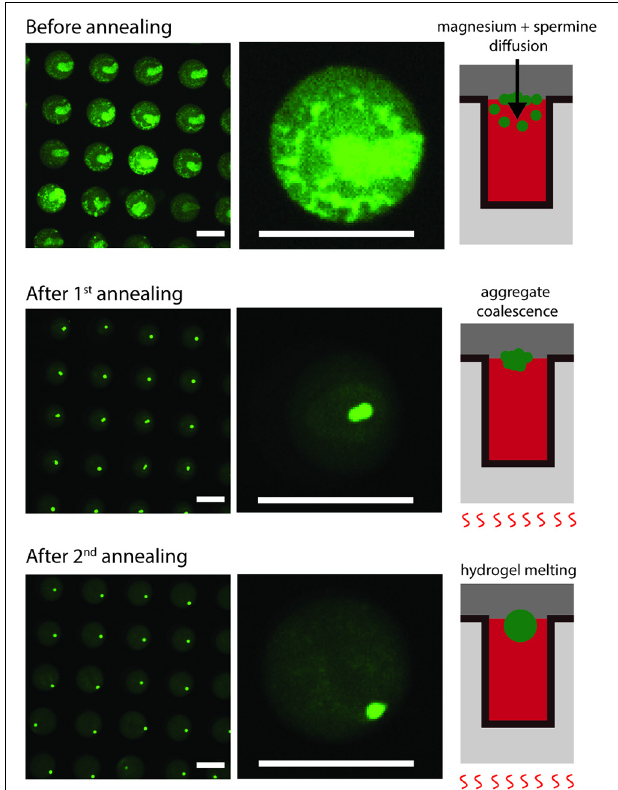
FIGURE 5 | Location of DNA aggregates in Dex/PEG microdroplet array before and after each annealing round (left and middle column) with a schematic model of particle formation (right column). Scale bars = 100 µ